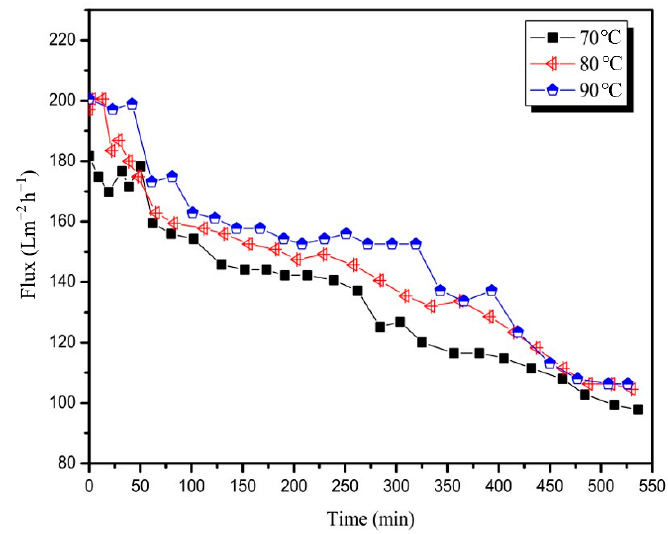
Figure 5. Variation in permeate flux with time for the 20 nm membrane at temperatures (TMP = 3 bar, CFV = 3 m/s).